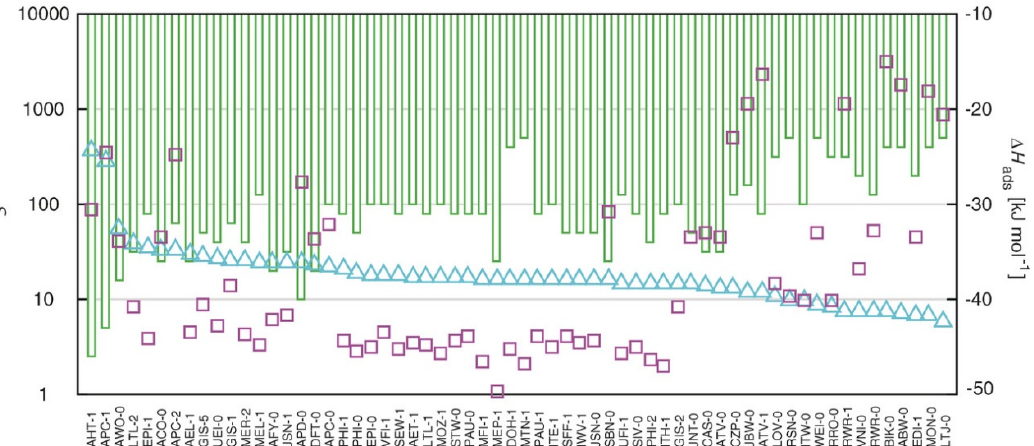
Figure 2. Selectivity (left axis) and Δ H ads (right axis) in top-performing zeolite structures at y F = 0.50, T = 343 K, and p = 50 bar. S H2S/CH4 cyan triangles, S H2S/C2H6 magenta squares, and Δ H ads (for the H 2 S/CH 4 mixture) green bars. Reprinted with permission from Ref. [49]. 2016, Wiley.